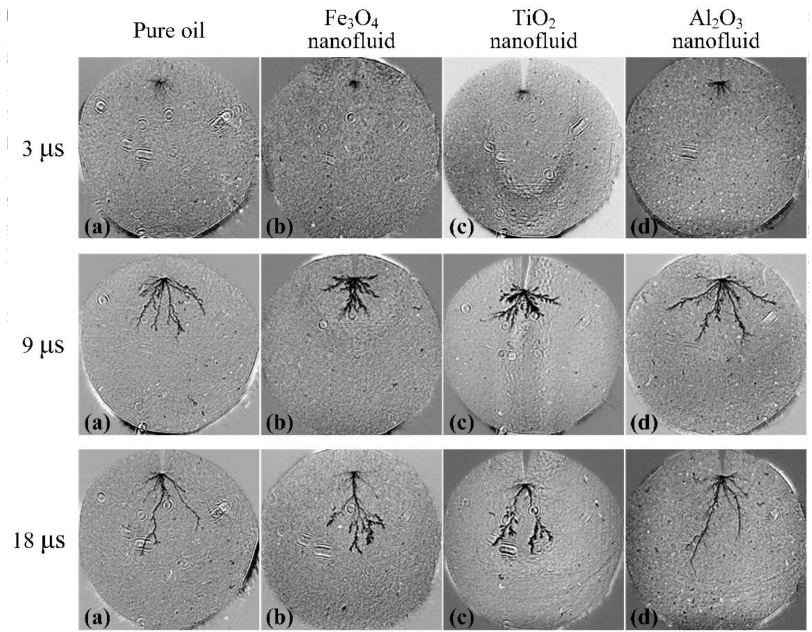
Figure 5. Prebreakdown streamers in pure oil and nanofluids. (a: pure oil, b: Fe 3 O 4 nanofluid, c: TiO 2 nanofluid and d: Al 2 O 3 nanofluid).